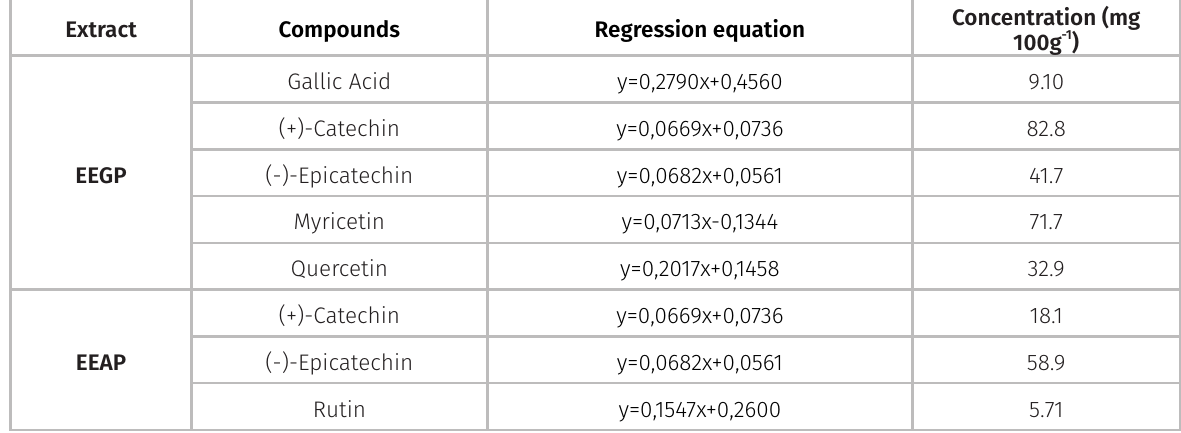
Regression equations obtained from analitical standards in